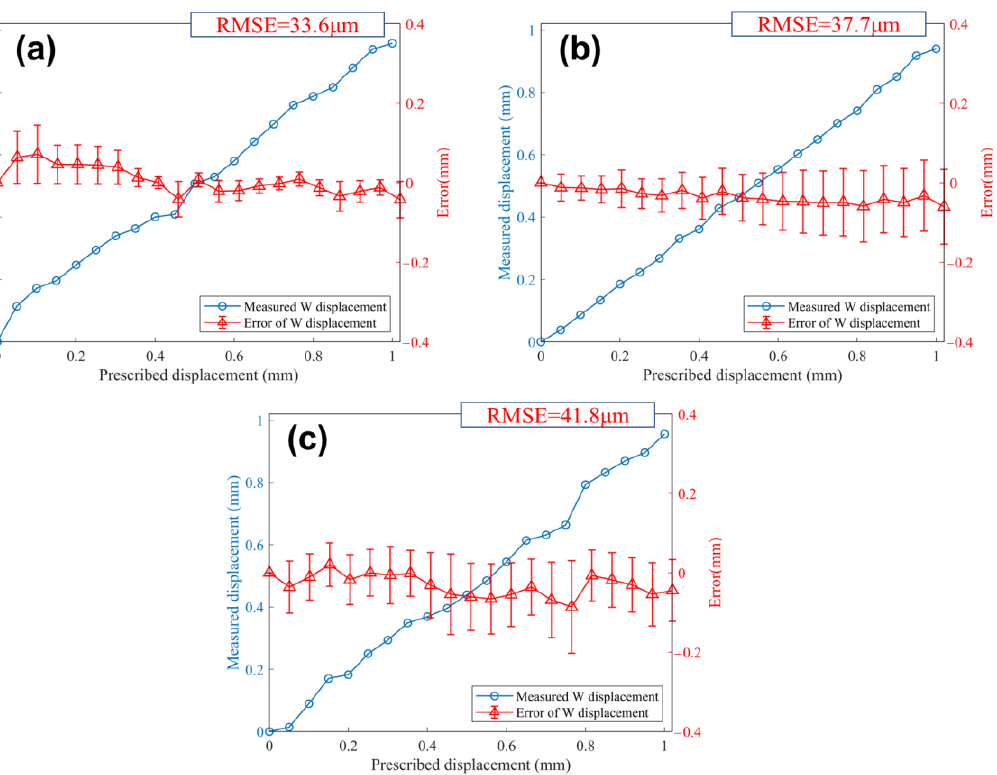
Figure 6. Results of the out-of-plane translation tests with working distances of ( a ) 500 mm, ( b ) 1000 mm, and ( c ) 1500